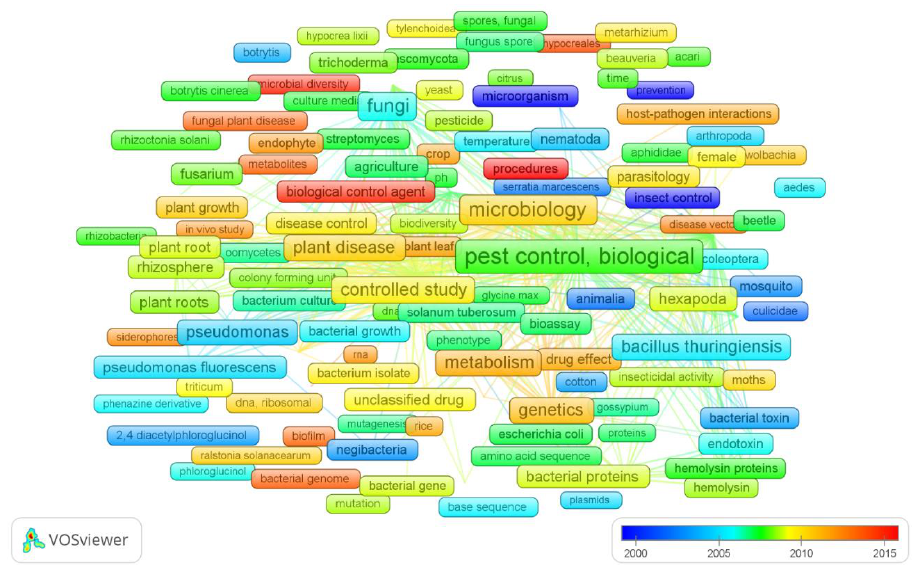
Figure 2. VOSviewer overlay visualization for “biological pest control” and “microorganism” from 1973 to 2020 (18 September). 1973 to 2020 (18 September).